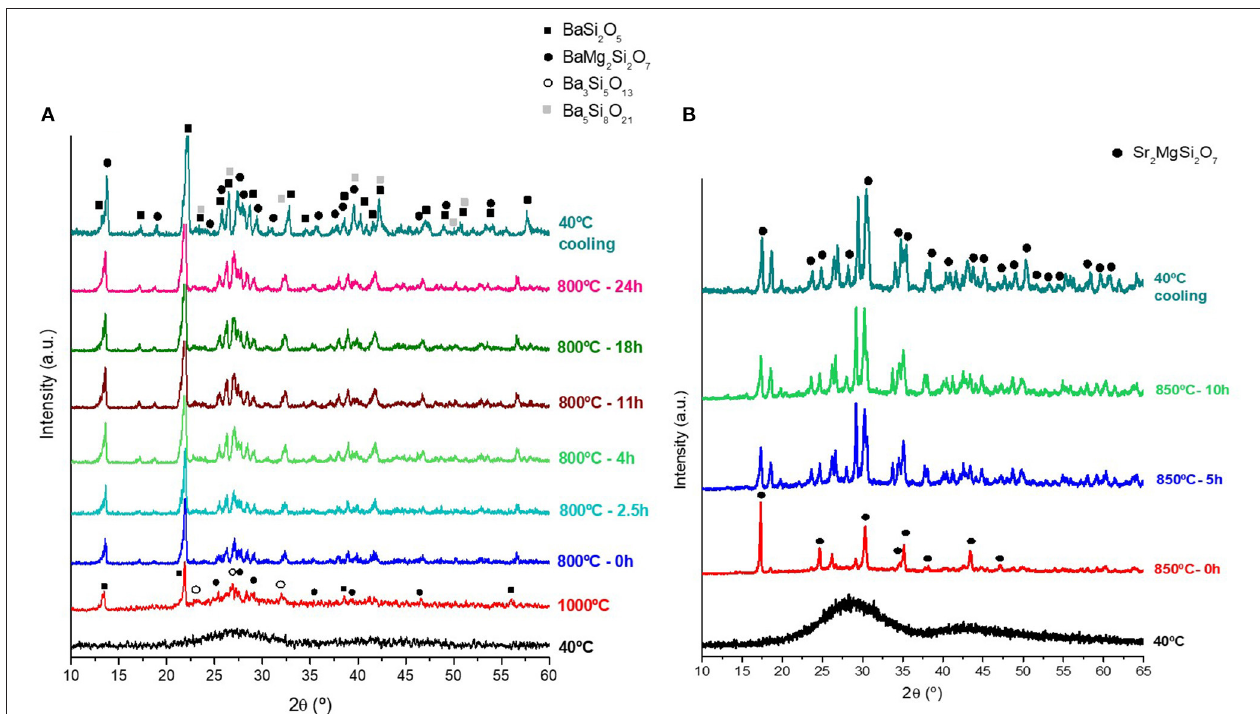
FIGURE 2 | (A) High temperature X-ray diffraction of composition 7.5B(Ba). Heating rate 2 ◦ C/min and scan rate 2 θ : 7 ◦ /min at 1000 ◦ C and 800 ◦ C − 0h and 2 ◦ /min for the rest of scans. (B) High temperature XRD of composition 10B(Sr). Heating rate: 2 ◦ C/min and scanning rate 2 θ : 0.5 ◦ /min.